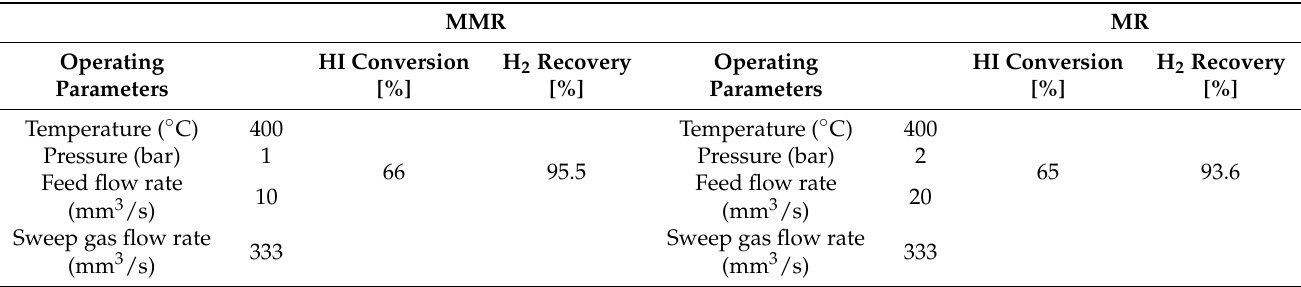
Table 3. Optimized operating condition to reach the best performance in the MR and MMR systems.